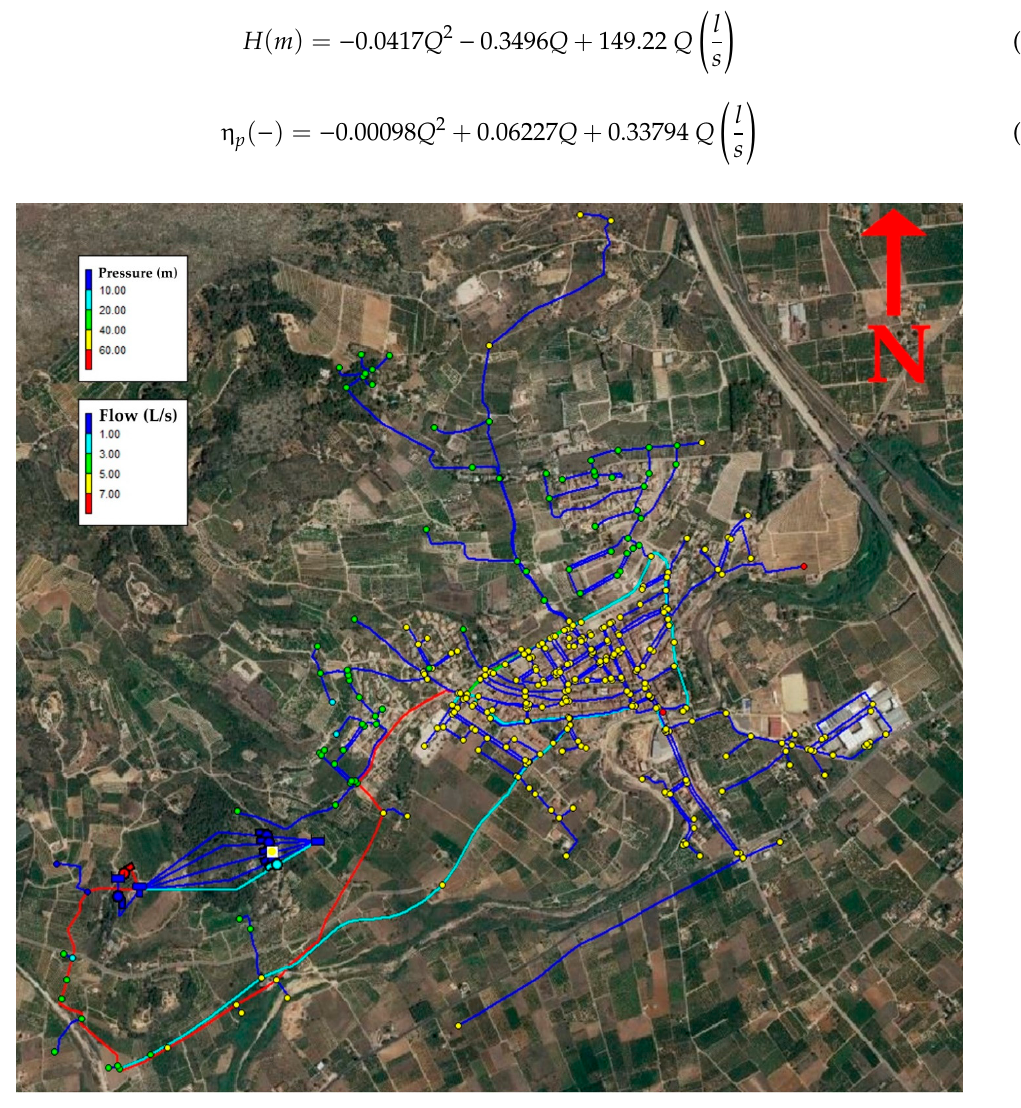
Figure 3. Town water pressurized network. Table 1. Water depth table, average temperature, and water consumption for each month. Month Water table depth